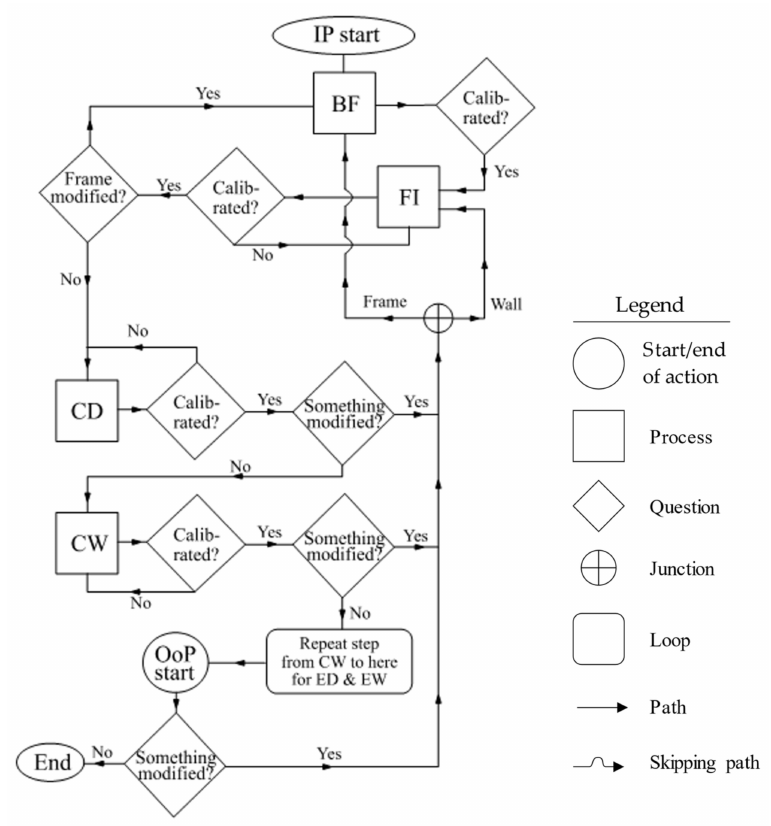
Figure 4. Calibration